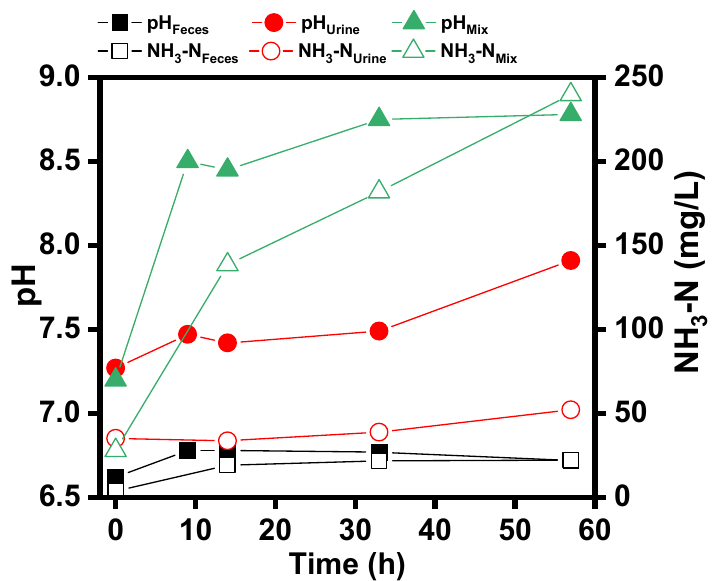
Figure 4. pH and NH 3 ‐ N variation for feces, urine, and their mixture.